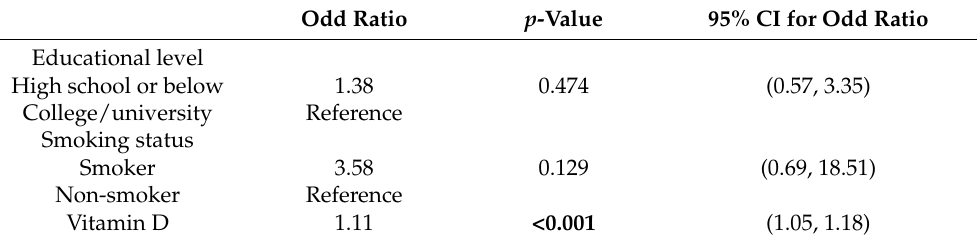
Table 7. Binary logistic regression of educational level, smoking status, and Vitamin D level